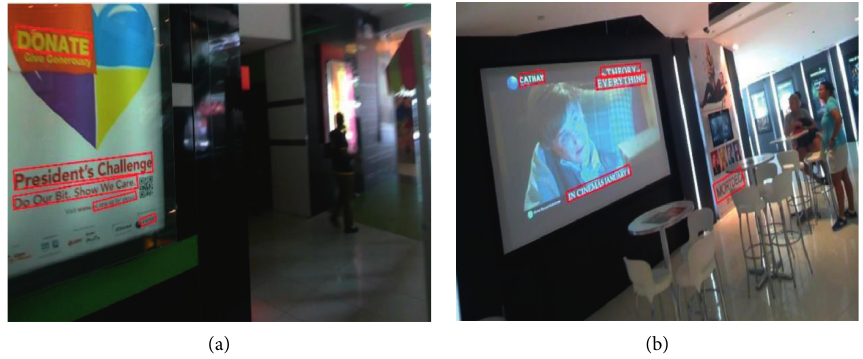
Figure 3: Recognition results of the AEMF algorithm from the ICDAR2015 dataset.